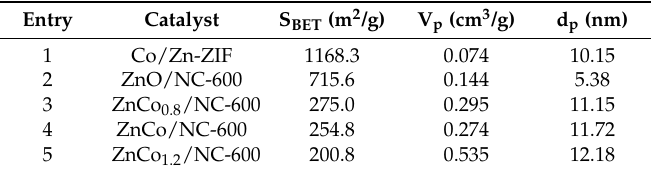
Table 1. Surface area, pore volume and average pore size of catalysts.